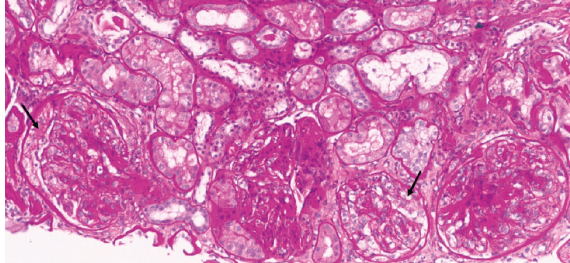
Figure 2: Early cellular crescents (arrows) are seen (PAS stain, original magnification, × 160). PAS: Periodic